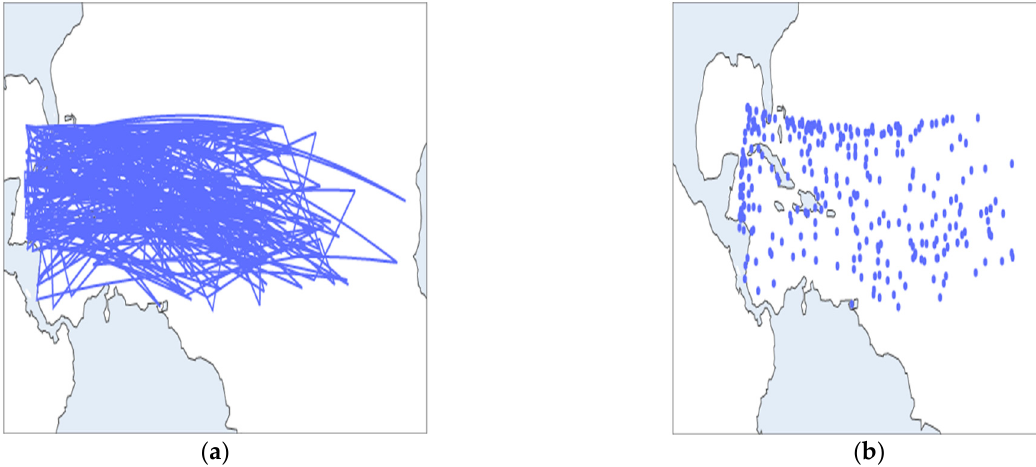
Figure 2. ( a ) Density of occurrence of storm; ( b ) point-wise density of occurrence of storm.